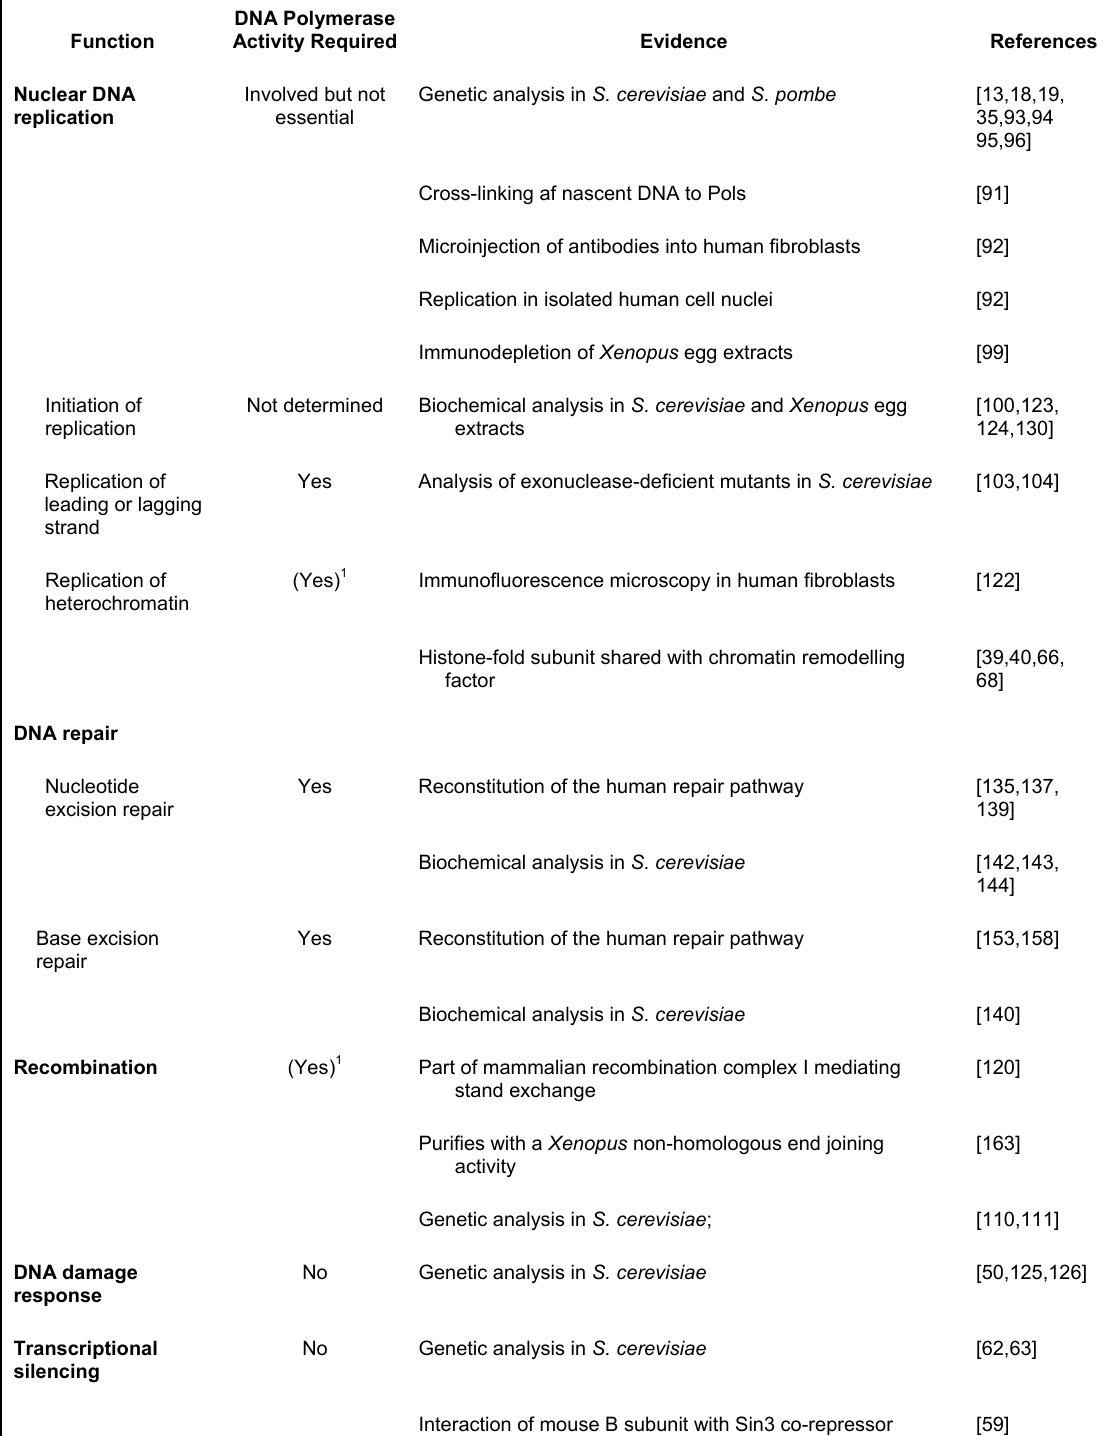
Proposed Functions of Pol ε and Their Dependence on the Catalytic Activity of the Enzyme